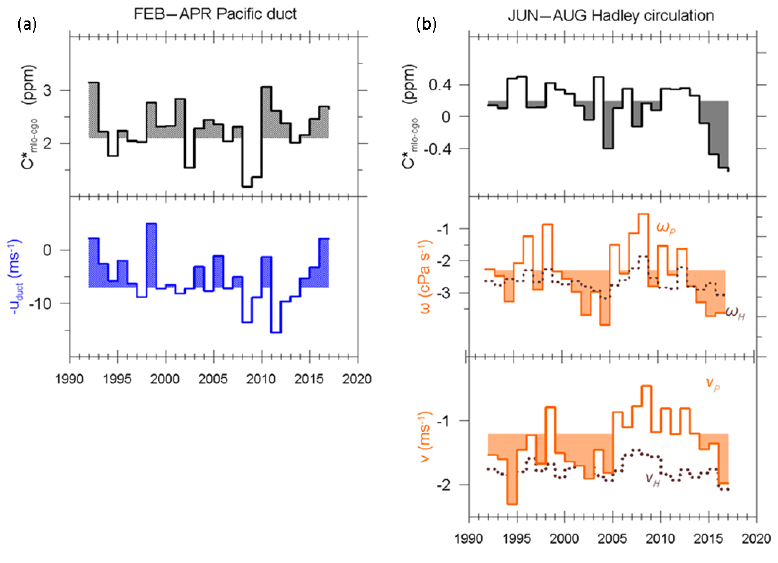
Figure 7. (a) C ∗ and − u duct averaged between February and April for 1992–2016 and (b) C ∗ mlo − cgo between June and August for 1992–2016.